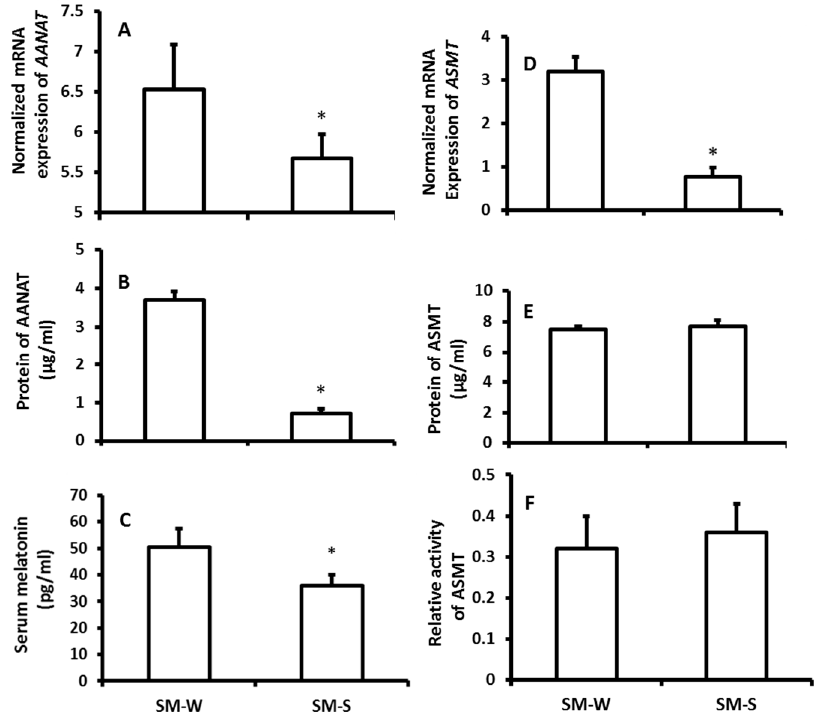
Figure 2. The effects of simulated-seasonal changes on the expressions of melatonin synthetic genes, AANAT and ASMT , in pineal gland and serum melatonin levels of hamsters. The animals were raised in the seasonal-simulated system for one month. The system simulated the local winter of 2015 (SM-W) and summer of 2016 (SM-S) climate changes including the temperature, photoperiod and humidity. The animals were sacrificed at 9–10 p.m. on the days of simulated winter solstice and summer solstice, respectively. Pineal glands were collected for melatonin synthetic gene expression assay, and serum was collected for melatonin assay. Animals were sacrificed under dim red light. A and B : mRNA and protein levels of AANAT , respectively; C : Serum melatonin level; D , E and F : mRNA, protein levels and activity of ASMT , respectively.The data were expressed as means ± SDs of 16 hamsters each group. The gene expressions were normalized against housekeeping gene actin and the changes was analyzed with the 2 − △△ Ct method. * Significant difference vs. SM-S.